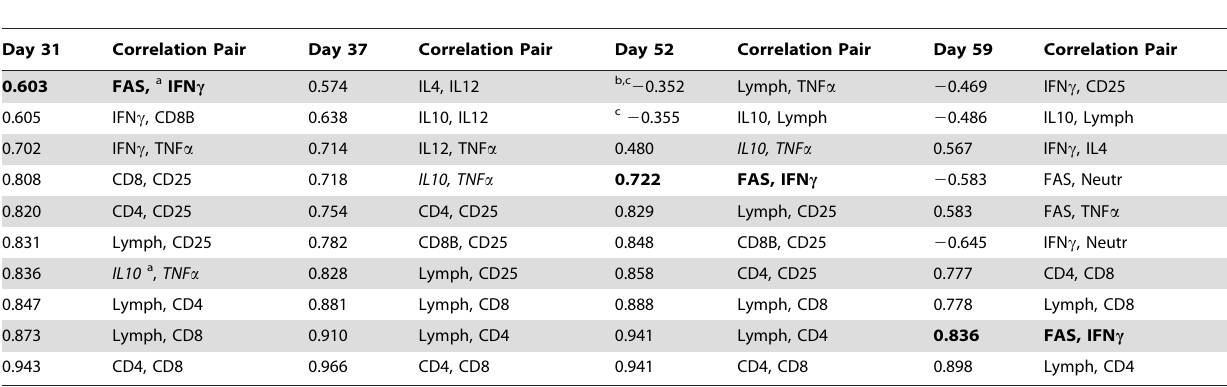
Table 2. Pearson’s coefficients of the ten strongest (absolute) pair-wise correlations between immunological responses for each day of analysis.